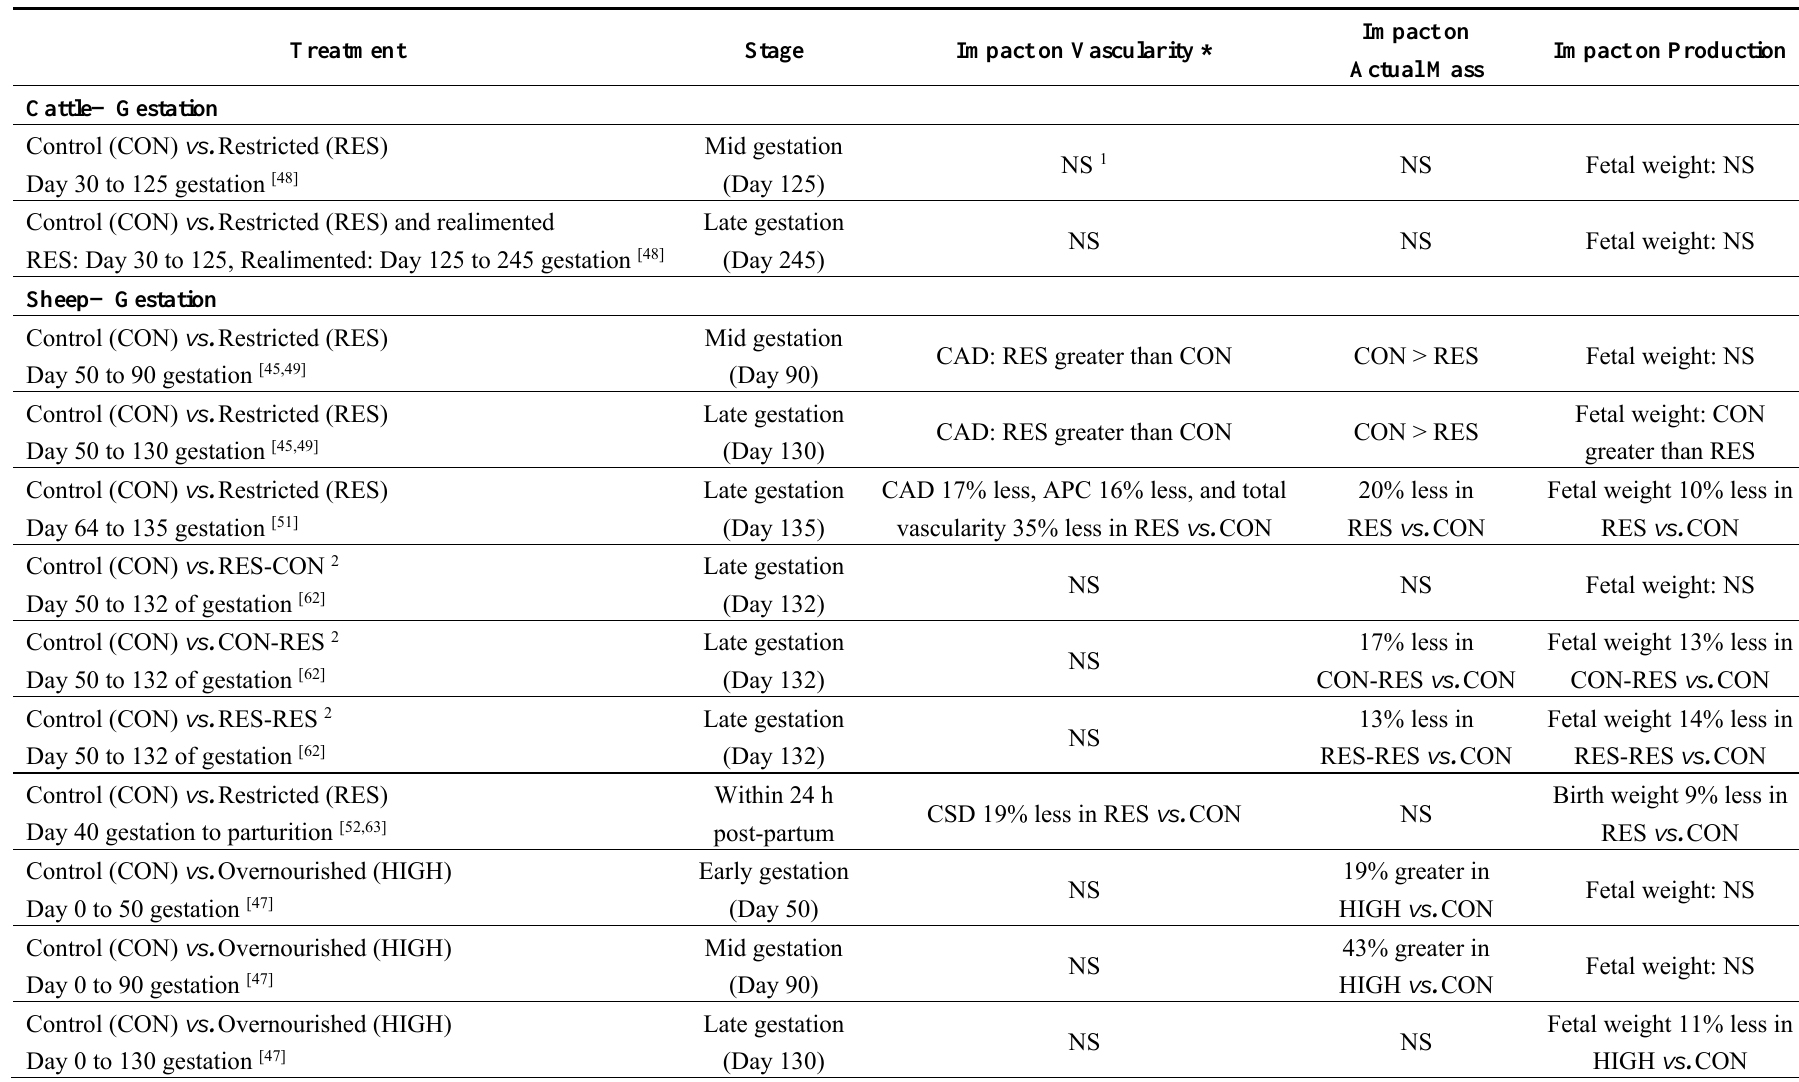
Table 3. Vascularity and mass of the maternal small intestine in ovine and bovine models for investigating the interrelationships of nutrition and reproduction. Treatment Stage Impact on Vascularity *